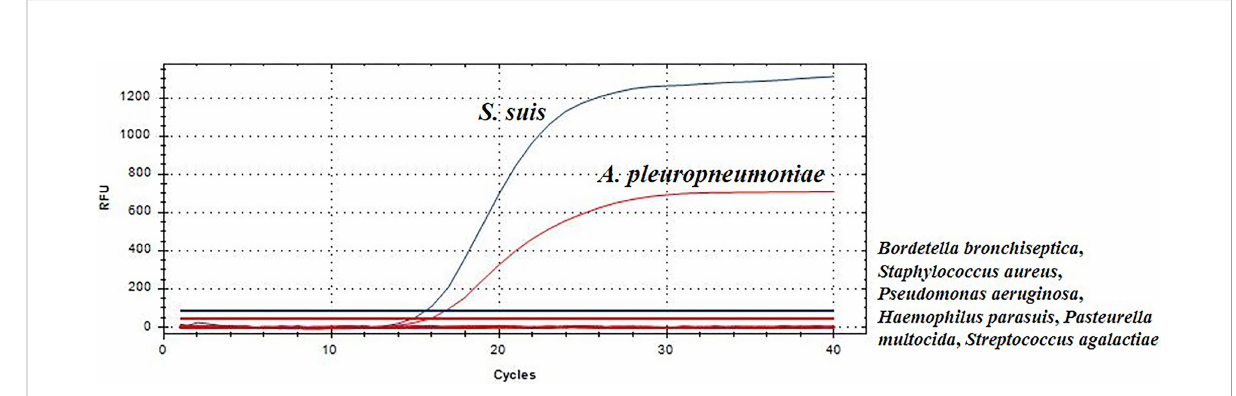
FIGURE 1 Evaluation of speci fi city of TaqMan real-time